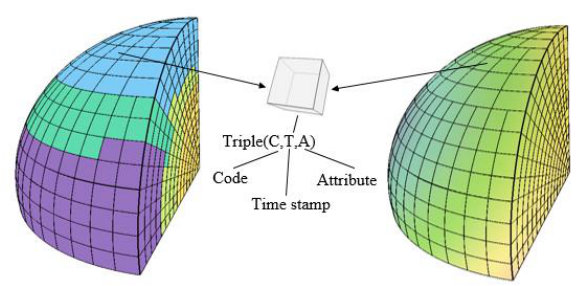
Fig. 2 Data representation in SDOG-ESSG